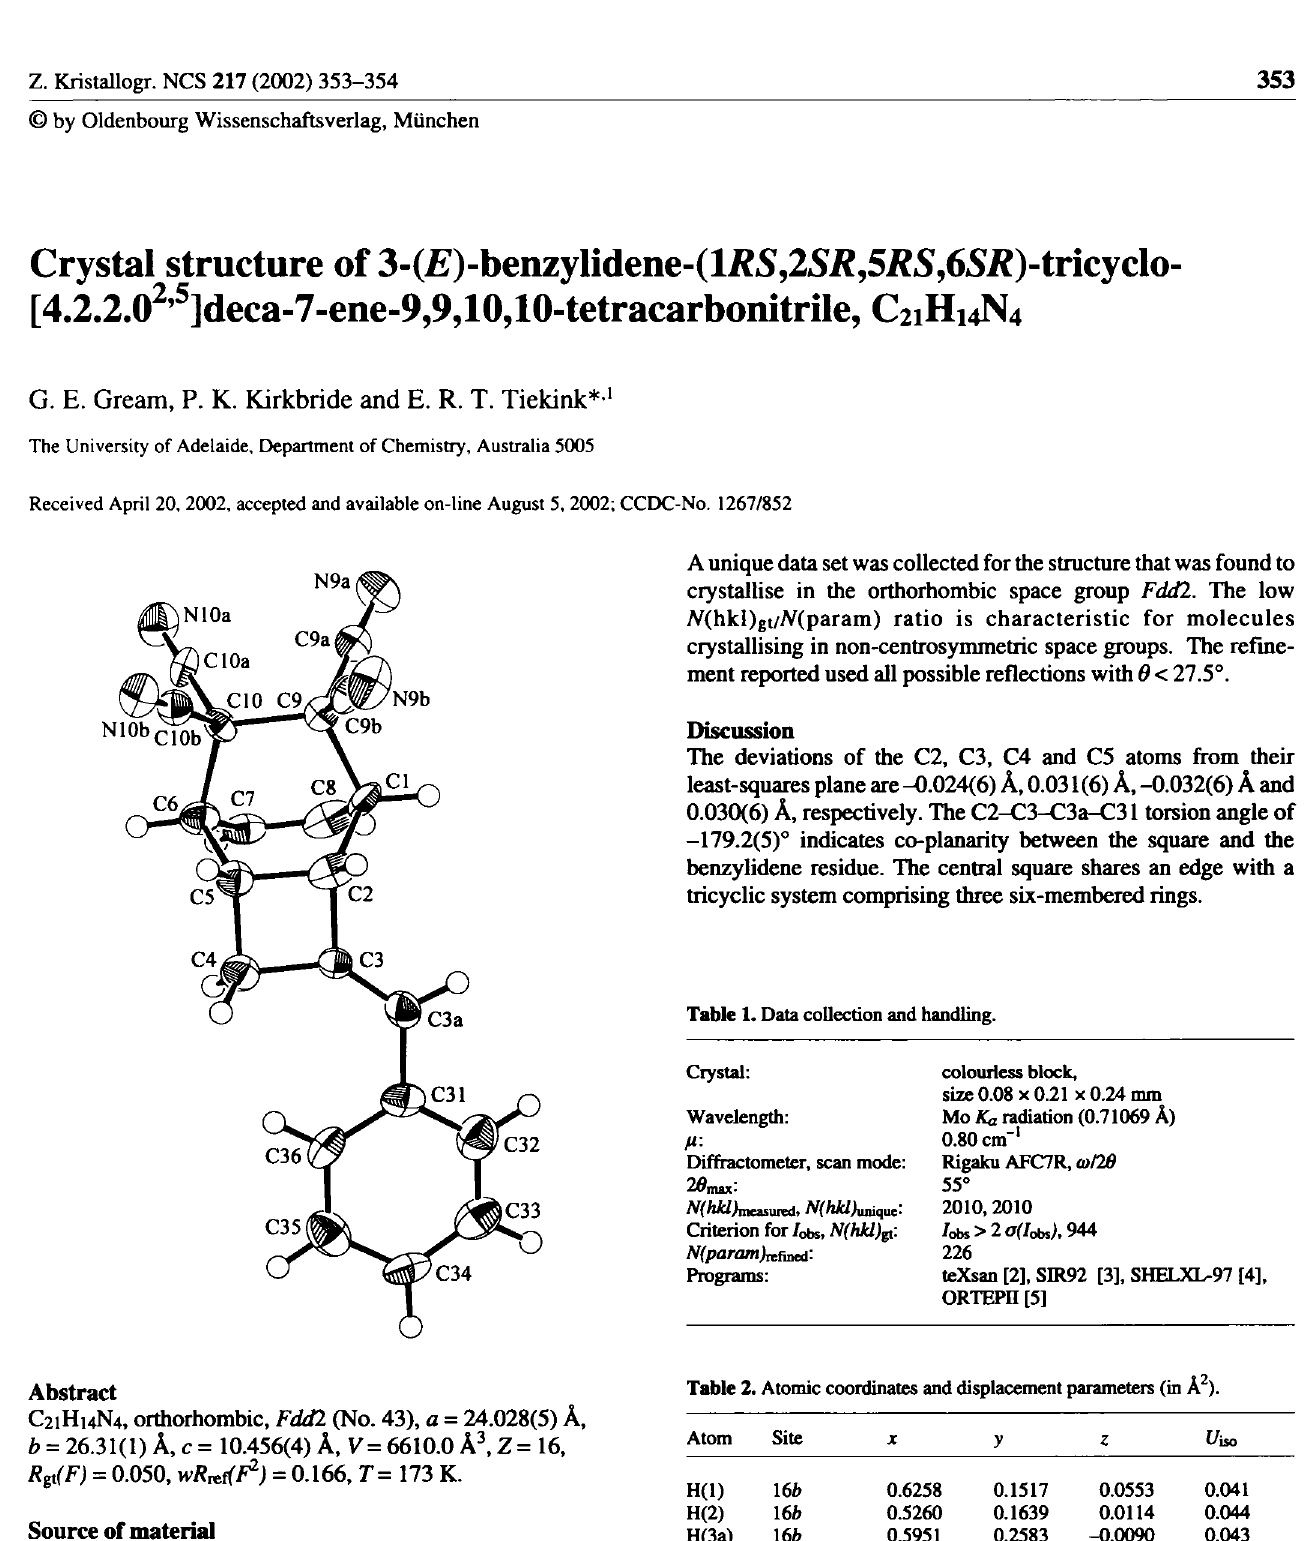
Table 2. Atomic coordinates and displacement parameters (in Â 2